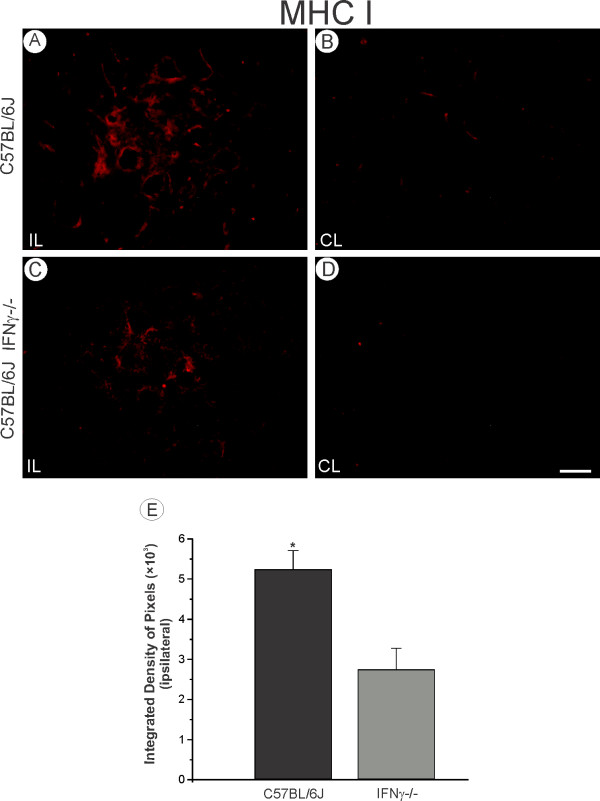
The MHC class I expression is increased in C57BL/6J (A, B) as compared to the IFNγ−/− mice (C, D). This fact was confirmed by the quantification of the integrated density of pixels in the neuropils adjacent to large motoneurons. (E; p < 0.05). Scale: 50 μm. MHC, major histocompatibility complex.